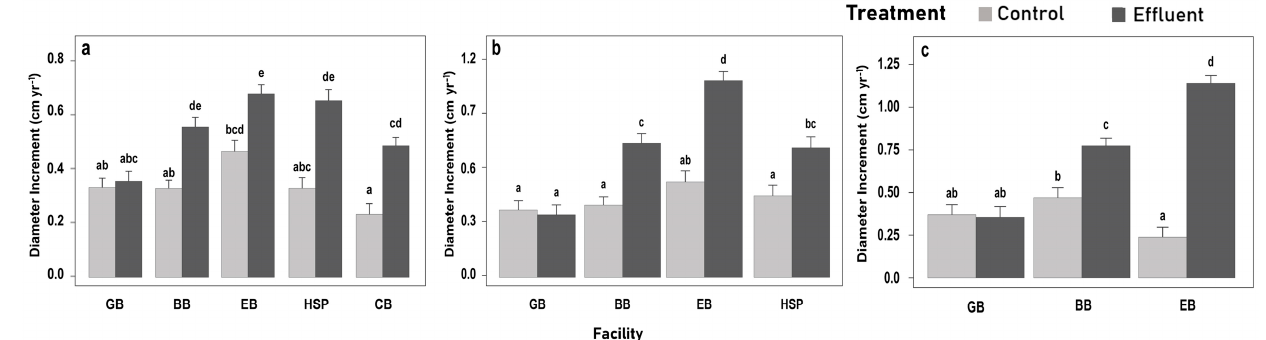
Figure 4. Mean and standard error ( n = 5) of five-year Diameter Increment during facility operation for ( a ) diameter increment period 2014–2018; ( b ) diameter increment period 2009–2014 and ( c ) diameter increment period 2004–2009 for all species combined. Same letters over bars within each panel indicate no differences between treatment levels at α = 0.10. Facility abbreviations are described in Figure 2. Facilities are arranged in establishment order with GB being first (1978) and CB being last (2013). Since treatment had not begun at some facilities, the number of facilities decreases for earlier